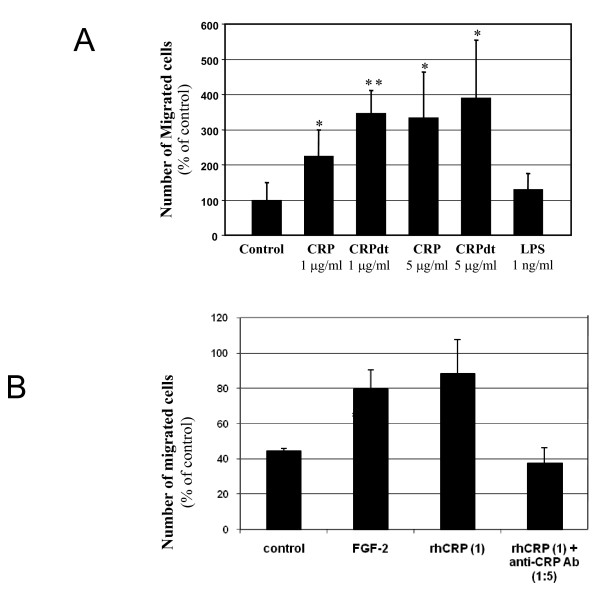
A, CRP induced a significant increase in chemotaxis in HCAEC. Cell migration was measured using a modified Boyden chamber as described in Methods. The effect of 1–5 μg/ml CRP (non-detoxified and detoxified CRP [CRPdt]) on HCAEC chemotaxis is shown. Endotoxin alone (LPS; 1 ng/ml) had no effect. B, Migration experiments were performed at least twice in triplicate wells. B, rhCRP (1 μg/ml) induced migration as compared with control and rhCRP (1 μg/ml)+antiCRP Ab(1:5). * and ** indicate a statistically significant difference compared with the control cells (p > 0.05 and 0.001 respectively).